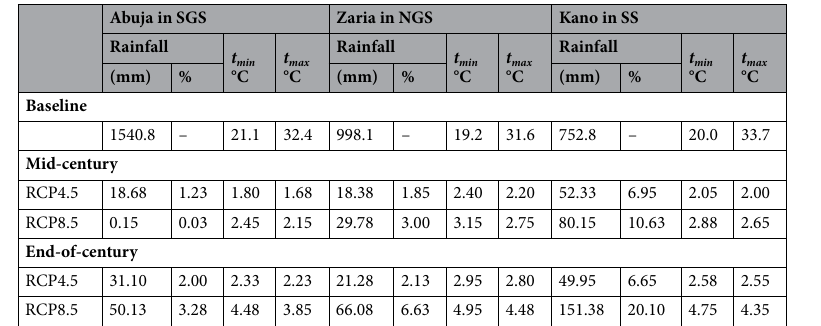
Table 4. Baseline and simulated ensemble annual climatic changes for rainfall, minimum and maximum temperatures for mid-century and end-of-century under RCP4.5 and RCP8.5 relative to the baseline data in SGS, NGS and SS of